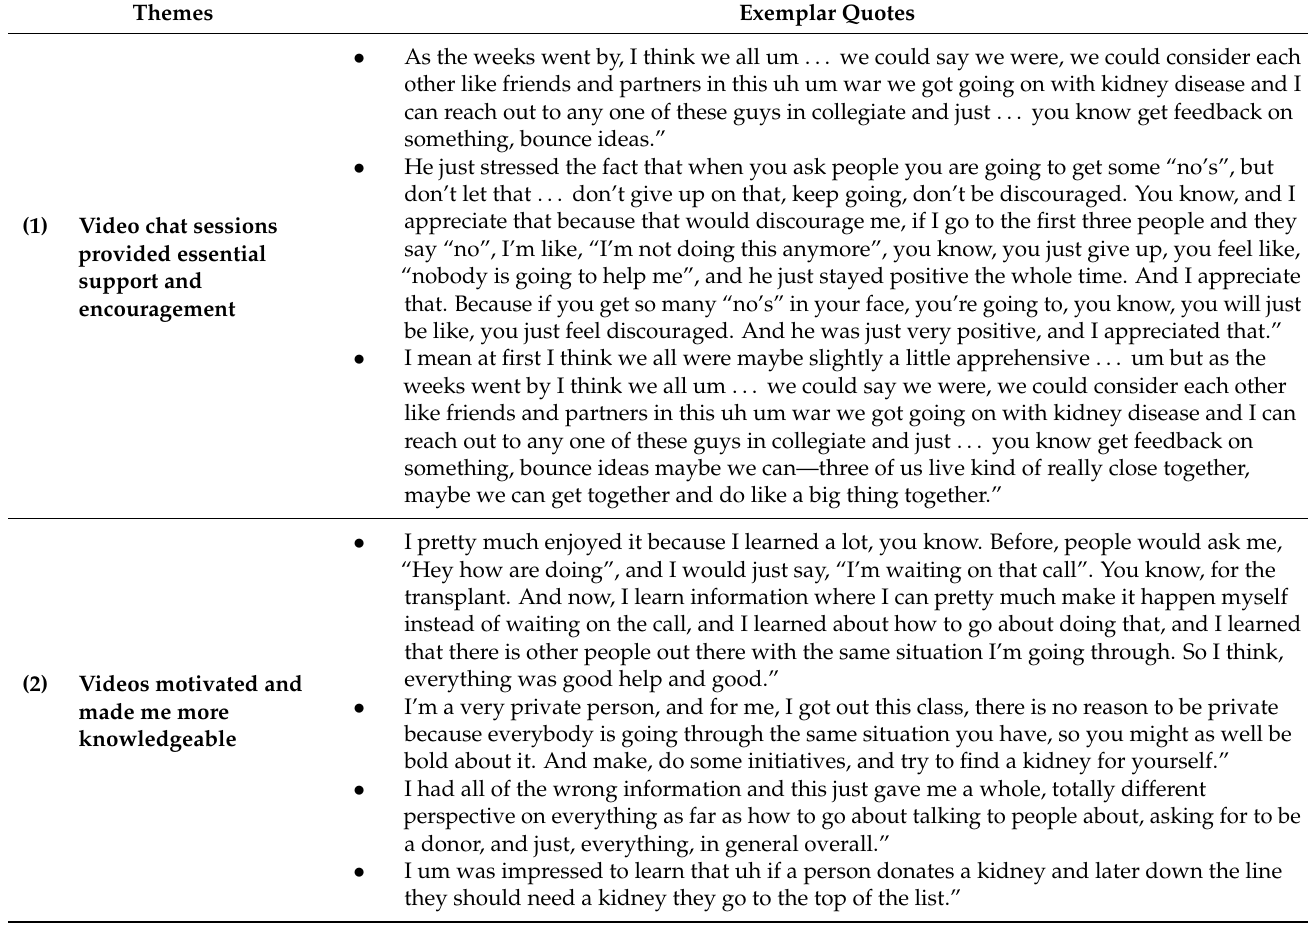
Table 3. Focus group themes on the LOVED